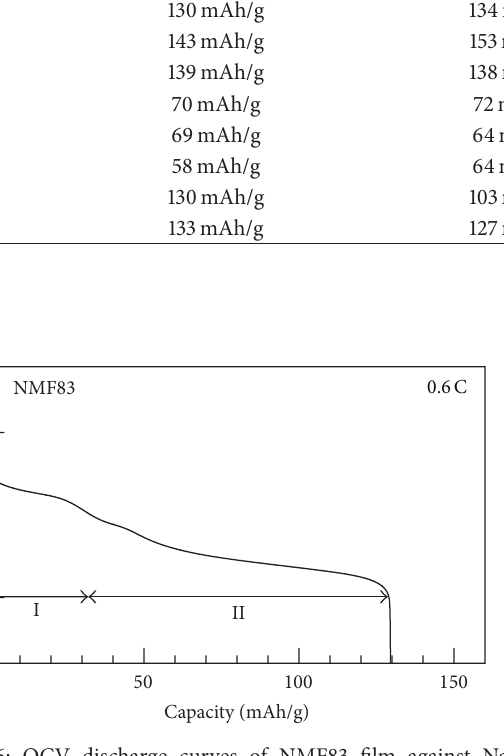
Figure 16: OCV discharge curves of NMF83 film against Na measured at 0.6C. For convenience of explanation, we define plateaus I and II (cited from [14]).